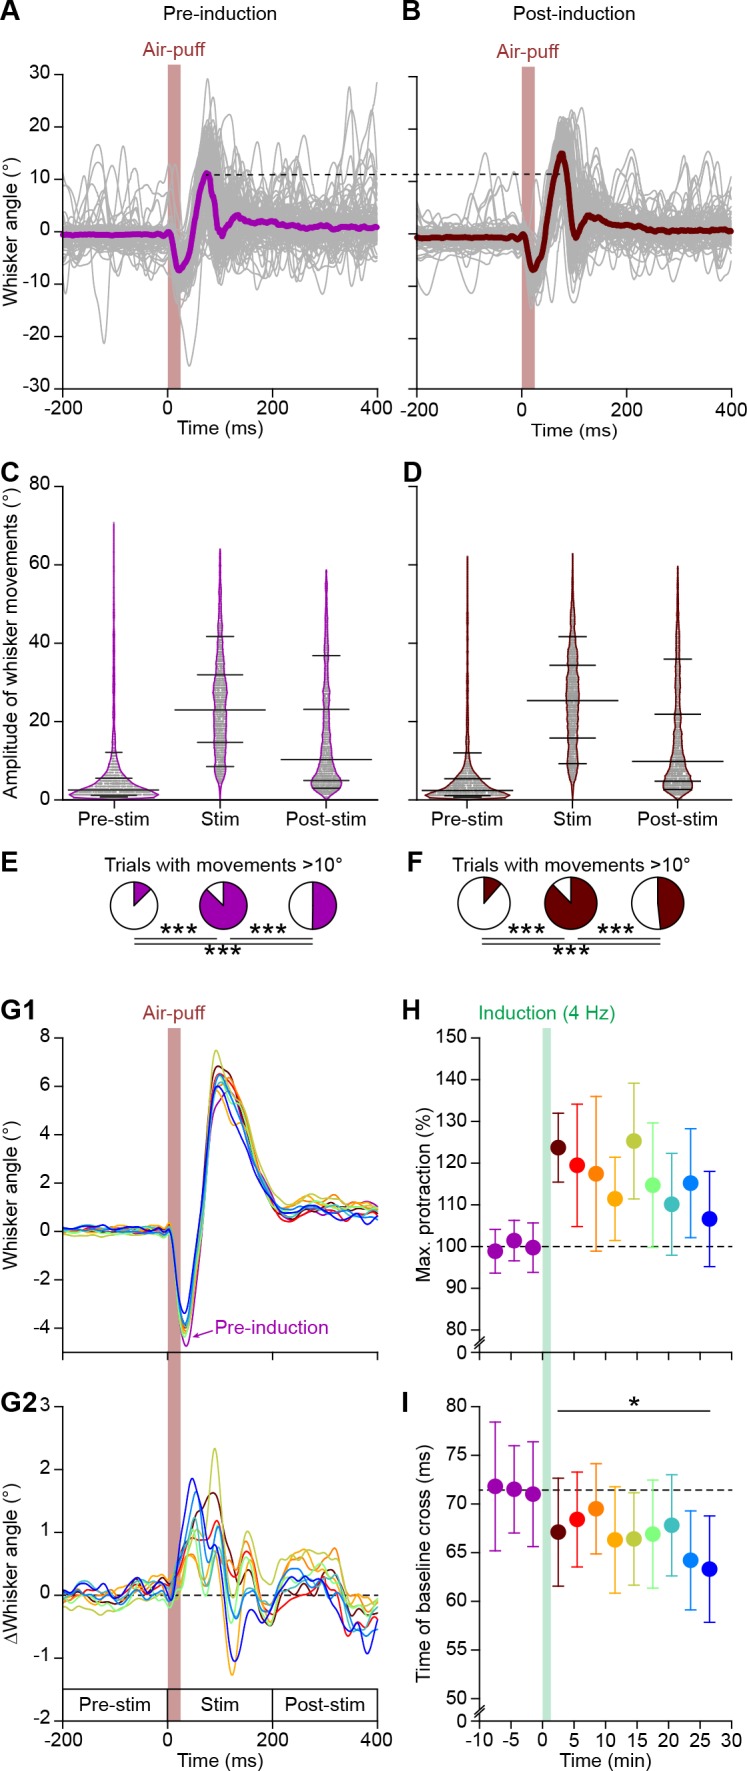
4 Hz air-puff stimulation enhances reflexive whisker protraction for at least 30 min.(A) The variability in whisker movements is illustrated by superimposing the average whisker angle during the 100 trials before 4 Hz air-puff stimulation. The thick line indicates the median. (B) The first 100 trials after induction of the same experiment as in (A), showing a clear increase in whisker protraction. Violin plots showing the amplitudes (differences between maximal retraction and maximal protraction in the indicated 200 ms intervals; see G2) of individual trials before (C) and after (D) induction. Obviously, the most prominent whisker movements were observed in the period between 0 and 200 ms after whisker pad air-puff stimulation, as compared to the 200 ms intervals before and after this period (n = 16 mice). Horizontal lines denote the 10th, 25th, 50th, 75th and 90th percentiles. Fractions of trials with movements exceeding 10° before (E) and after (F) induction. Especially the active protraction during the first 200 ms after the stimulus is clearly enhanced. Note that the panels (A), (C) and (E) are the same as in Figure 1—figure supplement 1 and are displayed here to illustrate the impact of 4 Hz stimulation on whisker movements. (G1) Averaged whisker traces (ordered per 100 trials) of seven mice where video data were available for the whole recording, showing less retraction and more protraction after induction. For clarity, only the average of the last 100 trials pre-induction is plotted. Color codes as in panel (H). (G2) Differential traces show that whiskers remain further protracted, but that over time this became faster. (H) 4 Hz air-puff stimulation caused increased whisker protraction during the whole recording (30 min). The switch from retraction to protraction (calculated as the time at which the whisker were back at the resting position after the initial retraction) remained faster throughout the recording (I). *p<0.05; ***p<0.001.